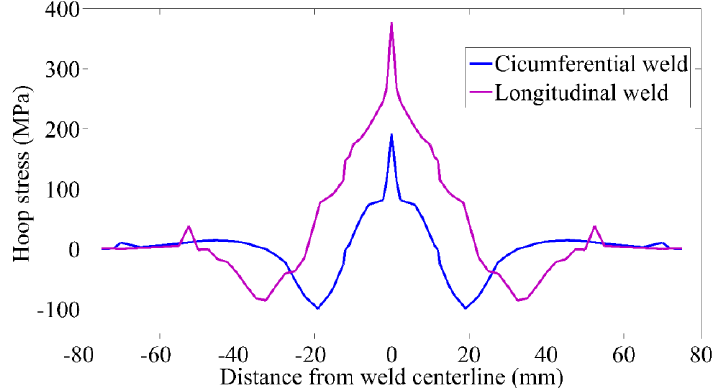
Fig. 15. Residual hoop stress distribution on the inner surface for circumferential and longitudinal weld butt